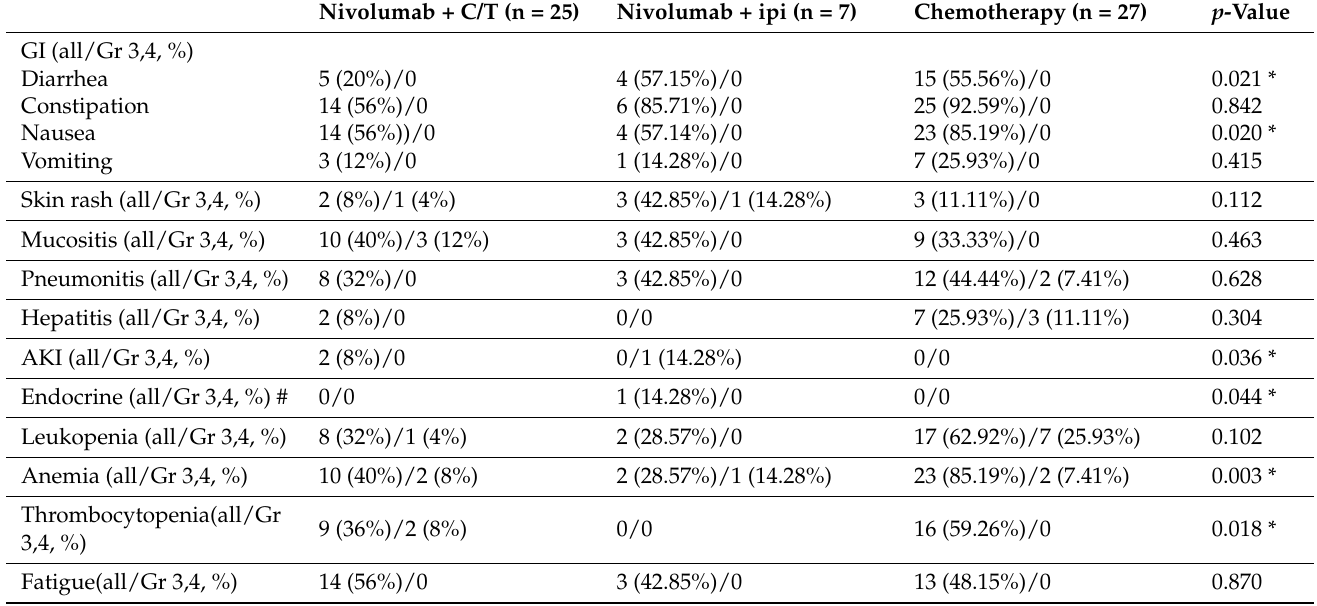
Table 4. Adverse effects.